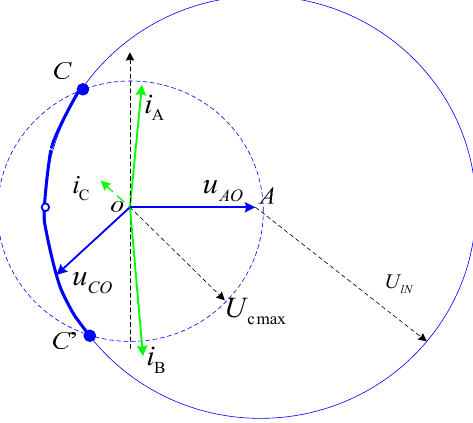
Figure 3. The basic voltage and current vector diagram of the testing system.